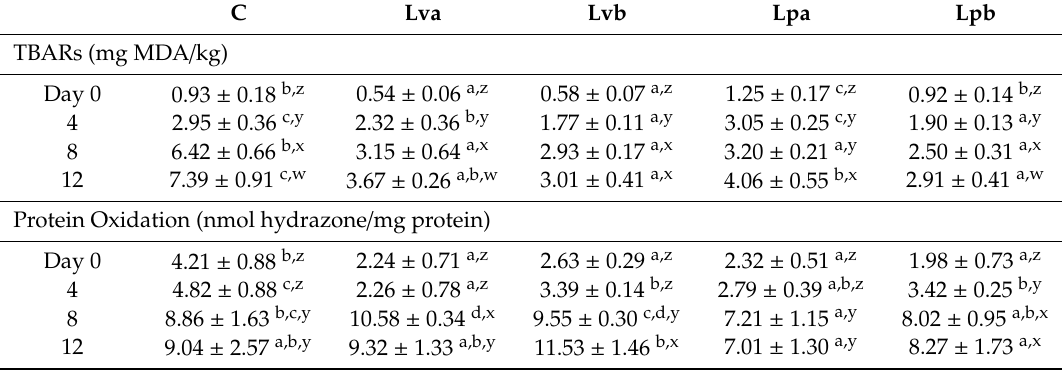
Table 3. Thiobarbituric acid-reactive substances (TBARs) and protein hydrazones (mean ± standard deviation) in deer burgers during chilled